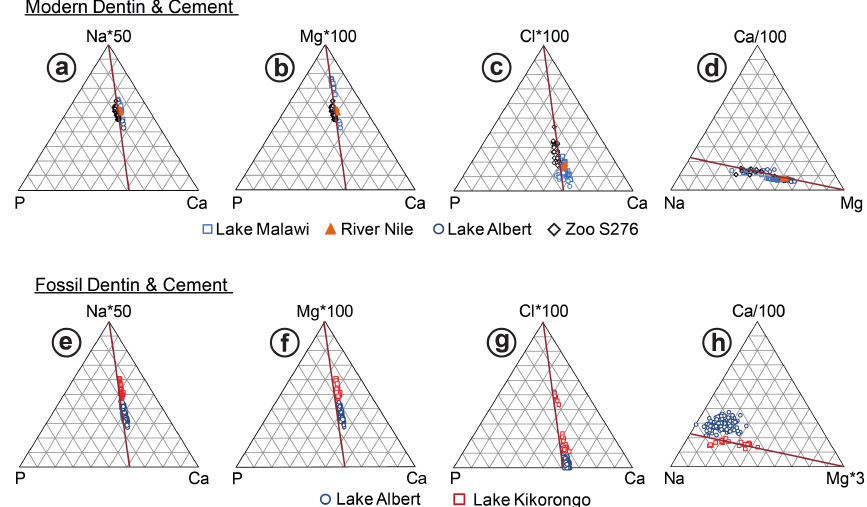
Fig. 6. Triangular diagram of chemical components (atomic proportions) in dentin and cement of modern and fossil Hippopotamid molar teeth. Dashed line defines trend of constant P/Ca ratio observed in modern enamel. (a–d) : distribution of Na*50-Ca-P, MgO*100-Ca-P, Cl*100-Ca-P,Ca/100-Mg*3-Na respectively, in modern dentin and cement (e–h) : distribution of Na*50-Ca-P, MgO*100-Ca-P, Cl*100-Ca- P,Ca/100-Mg*3-Na, respectively, in fossil dentin and cement.